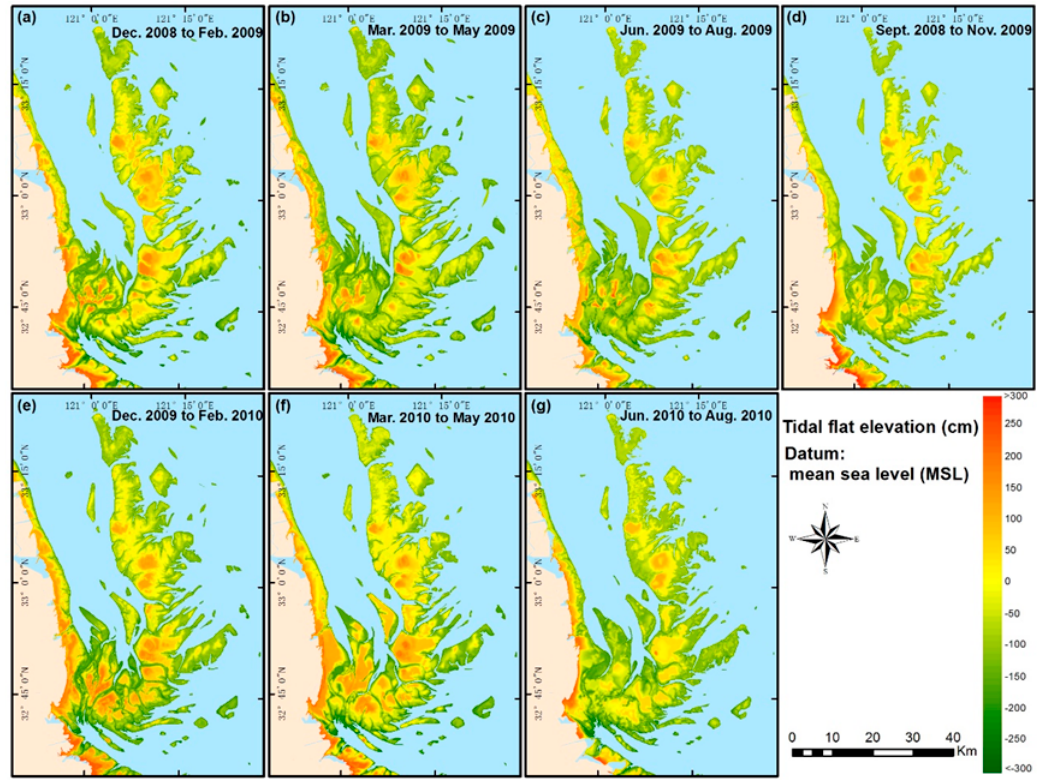
Figure 3. DEMs of the central Jiangsu coast from December 2008 to August 2010. ( a ) Winter 2008 (December 2008 to February 2009); ( b ) spring 2009 (March to May, 2009); ( c ) summer 2009 (June to August, 2009); ( d ) autumn 2009 (September to November, 2009); ( e ) winter 2009 (December 2009 to February 2010); ( f ) spring 2010 (March to May, 2010); and ( g ) summer 2010 (June to August, 2010). The datum of the DEMs is the mean sea